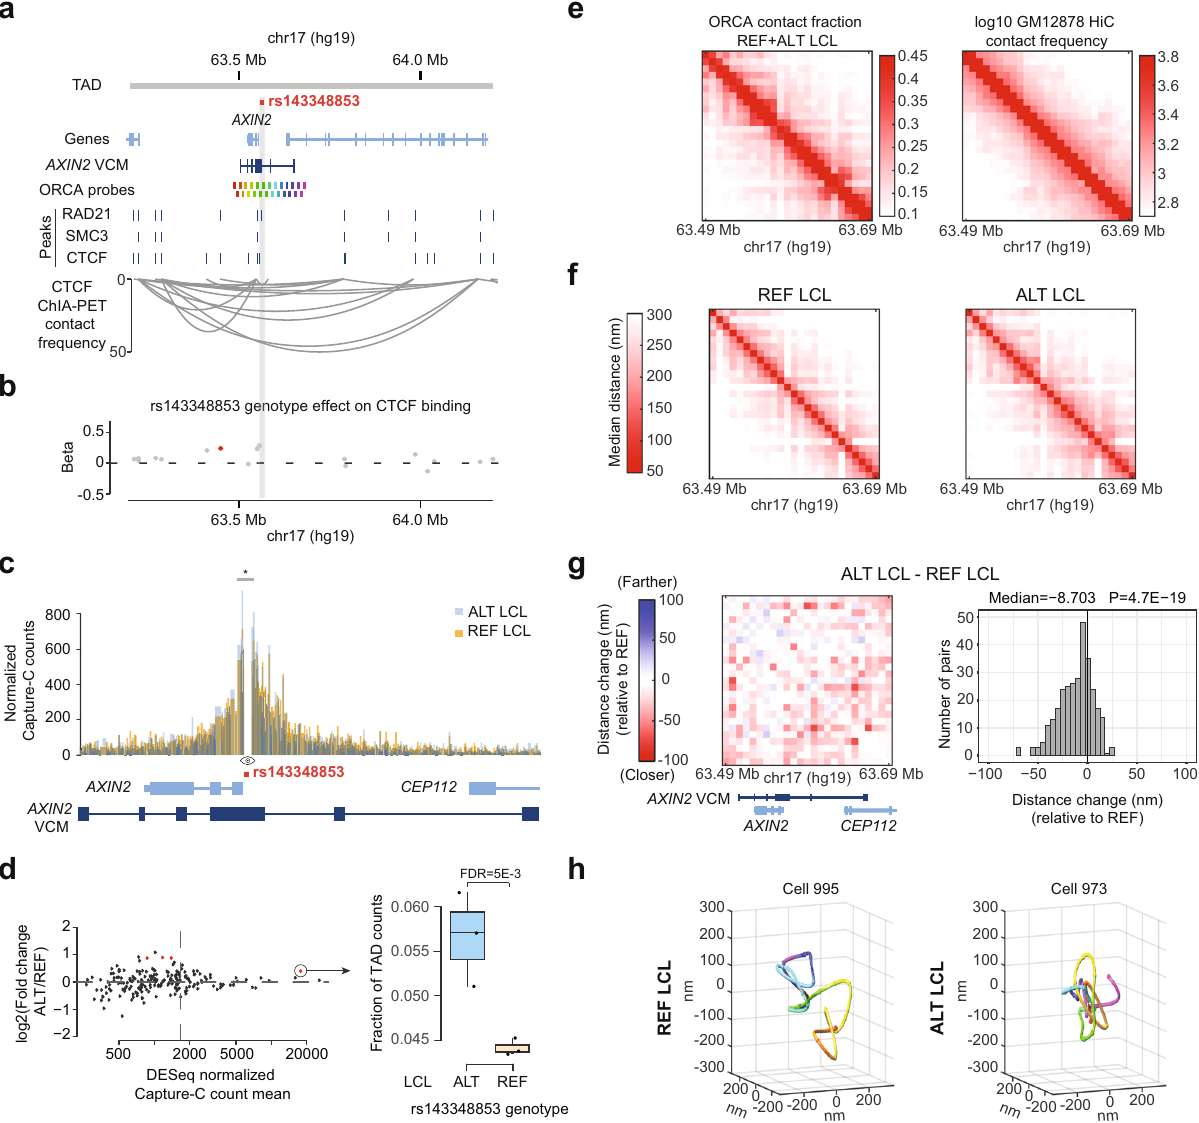
Fig. 6 Global chromatin compaction of the AXIN2 VCM region on the ALT allele. a Genomic view of the AXIN2 locus showing the GM12878 AXIN2 TAD 72 , the LCL AXIN2 VCM, the DNA probes used for ORCA, binding sites for RAD21, SMC3, and CTCF in GM12878 from ENCODE, and CTCF ChIA-PET interactions from GM12878 49 . b Genetic effect (beta) of the rs143348853 genotype on CTCF binding in LCLs. Signi fi cant values (FDR < 0.05) are labelled in red based on FDR corrected p -values from a linear regression model. c Histogram of the TAD-normalized Capture-C counts from merged replicates for the ALT and REF LCLs. The viewpoint is marked with an eye (indel) and the signi fi cant 5 kb bin with differential interaction between the two alleles is marked with a gray box and * (based on DESeq2 results). d Log2 fold change of ALT vs. REF normalized and binned (bin-size = 5 kb) Capture-C counts as obtained by DESeq2 (FDR < 0.05 highlighted in red) (the vertical line represents the average count per bin across the AXIN2 TAD, used as a signal to noise threshold) (left panel). Boxplot of the fraction of TAD counts falling within the 5 kb bin around the viewpoint, containing the AXIN2 promoter (see c , gray box and *) ( n = 3 biological replicates) (right panel). Boxes indicate the IQR (25 – 75%) and the box center indicates the median. Whiskers represent de minimum or maximum values of no further than 1.5 times the IQR for both the top and bottom of the box. e ORCA contact fraction <150 nm for the merged REF and ALT LCL data (left) and log10 GM12878 HiC contact frequency on the same genomic region (right). f Population-median distance in nm for each pair of ORCA segments for REF and ALT LCLs. g Matrix (left) and histogram (right) showing the differences between pairs of ORCA segments of population-median distances of REF and ALT alleles. P indicates p -value from a two-sided binomial test. h Polymer reconstruction of the LCL AXIN2 VCM 3D architecture obtained by ORCA from one representative LCL single cell for the REF and ALT genotype. The segments are color-coded as illustrated in a